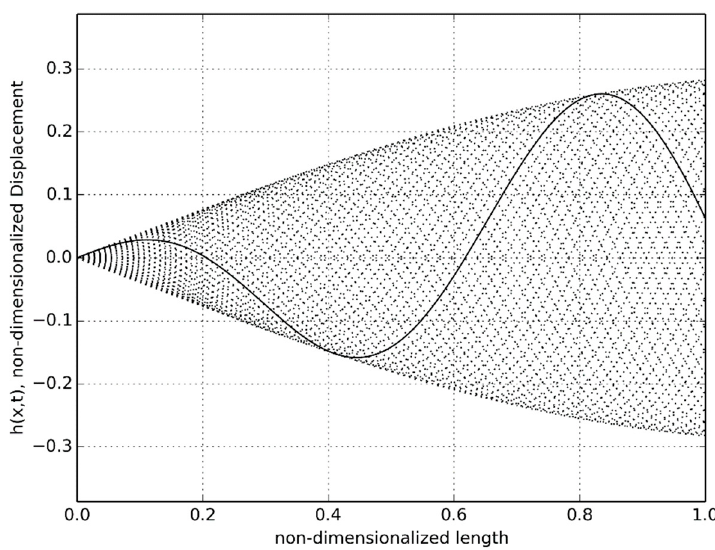
Figure 2. Nondimensionalized undulatory displacement over time.